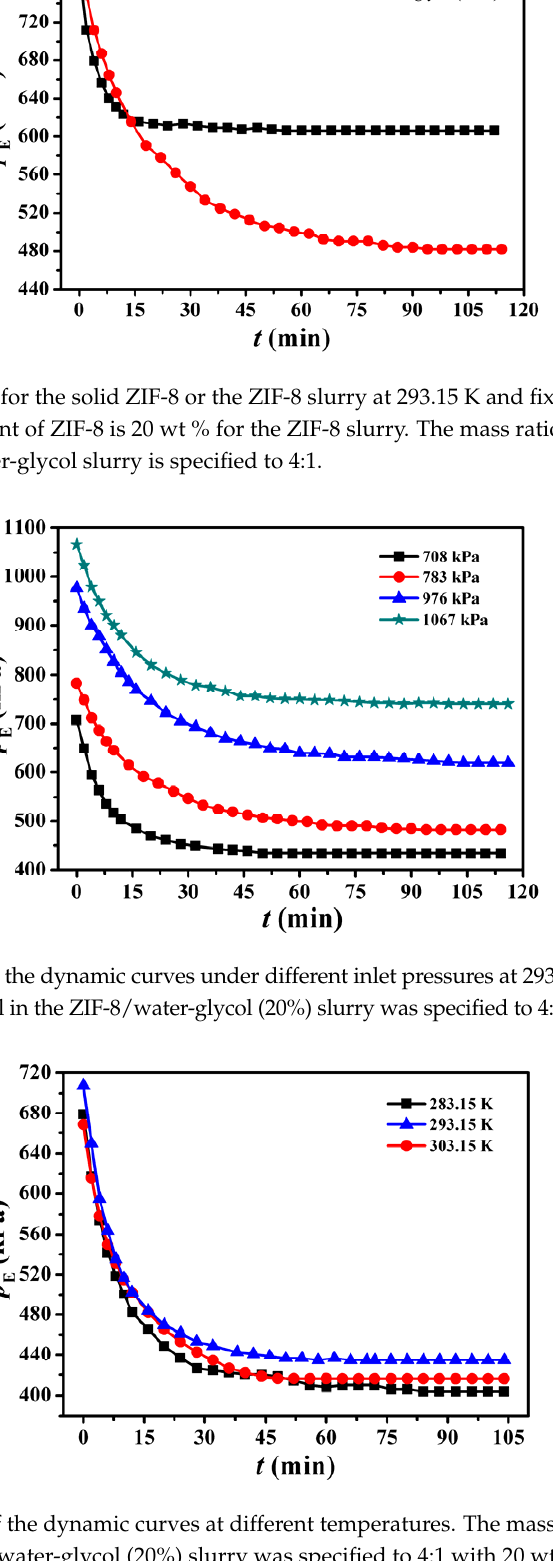
Figure 9. Comparison of the dynamic curves at different temperatures. The mass ratio between water and glycol in the ZIF ‐ 8/water ‐ glycol (20%) slurry was specified to 4:1 with 20 wt % ZIF ‐ 8.